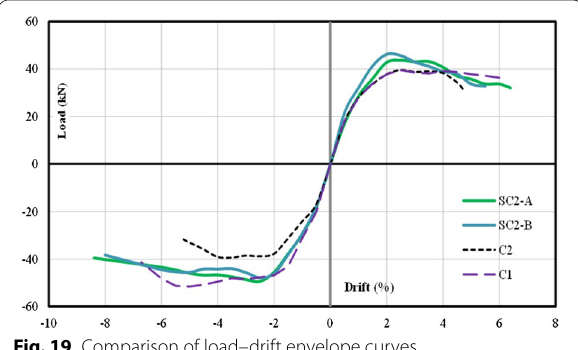
Fig. 19 Comparison of load–drift envelope curves.